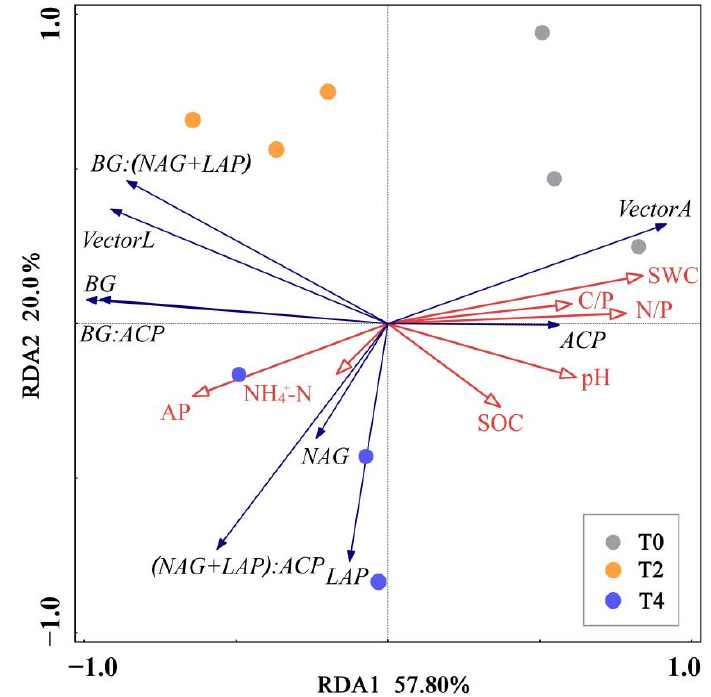
Figure 5. Redundancy analysis (RDA) of soil properties, soil enzyme activities, and microbial C, P